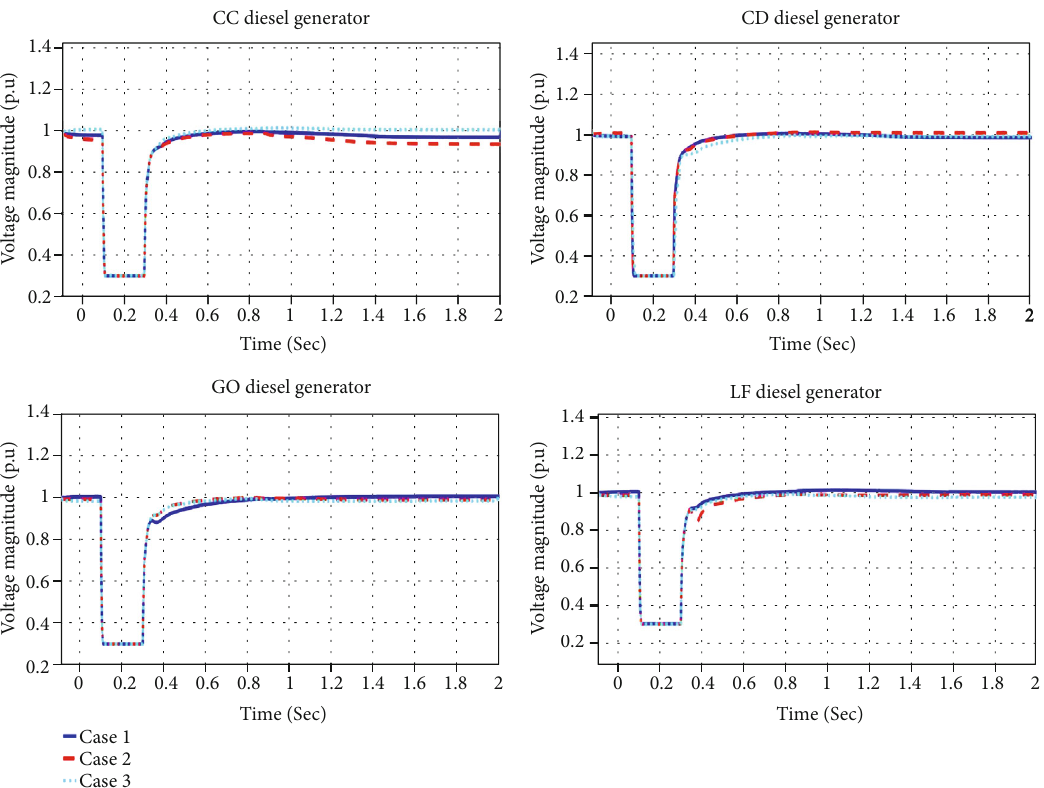
Figure 16: Voltage magnitudes from diesel generator module for four dispatch strategies. This fi gure is reproduced from Shezan et al.